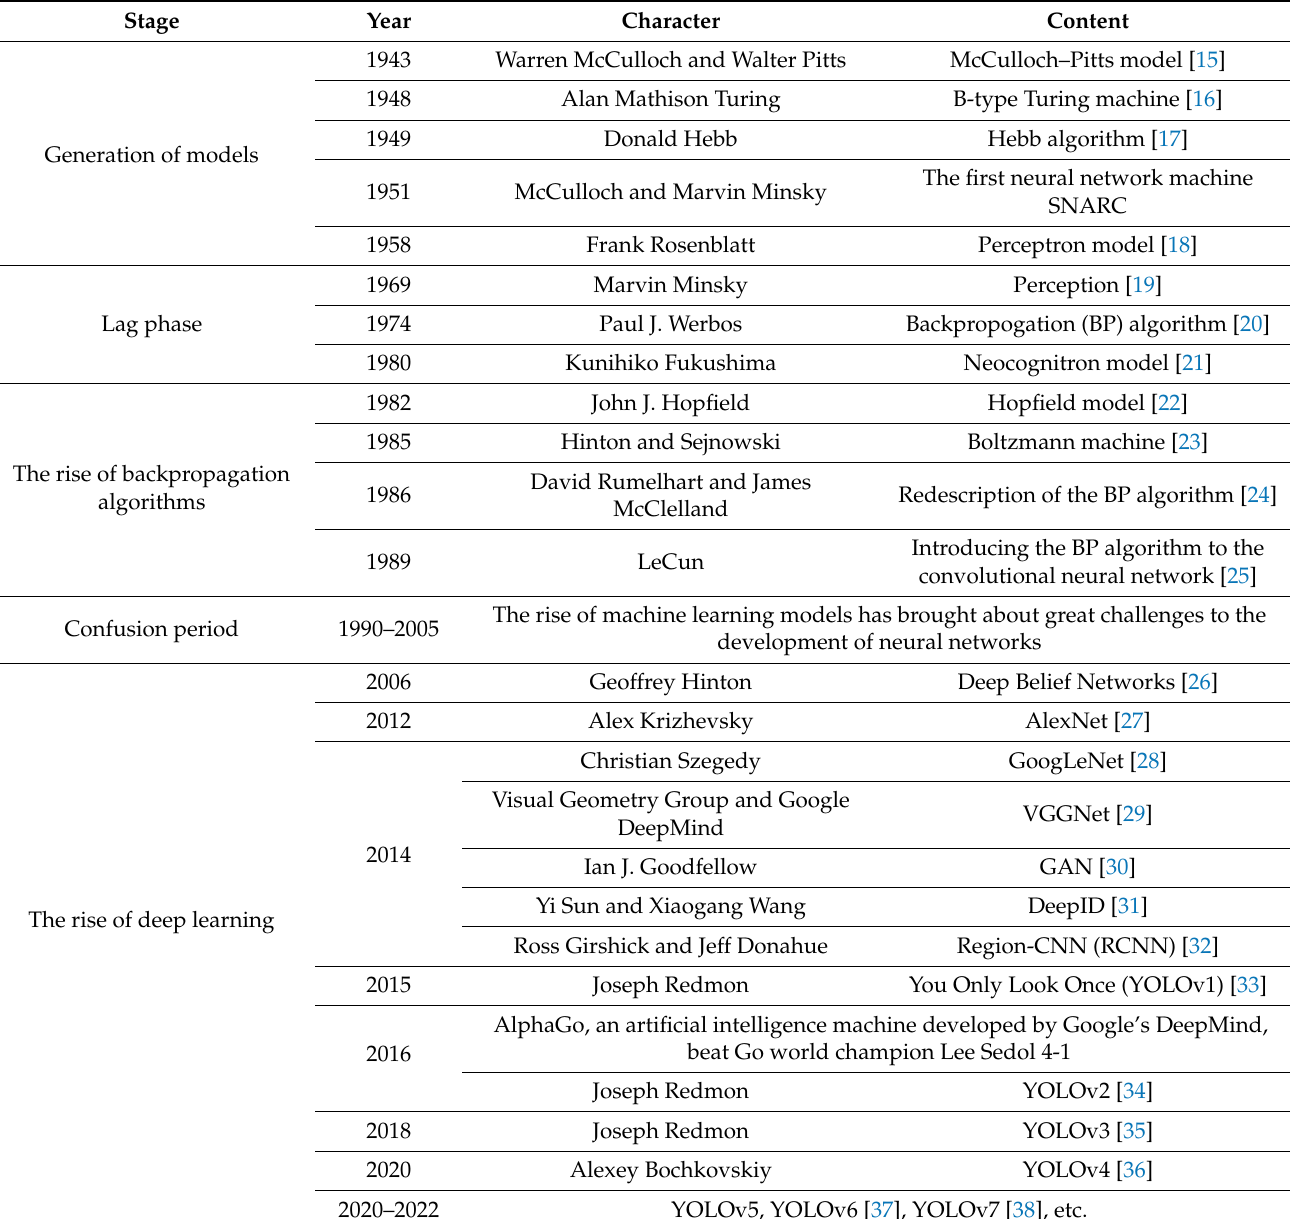
Table 1. Development history of neural